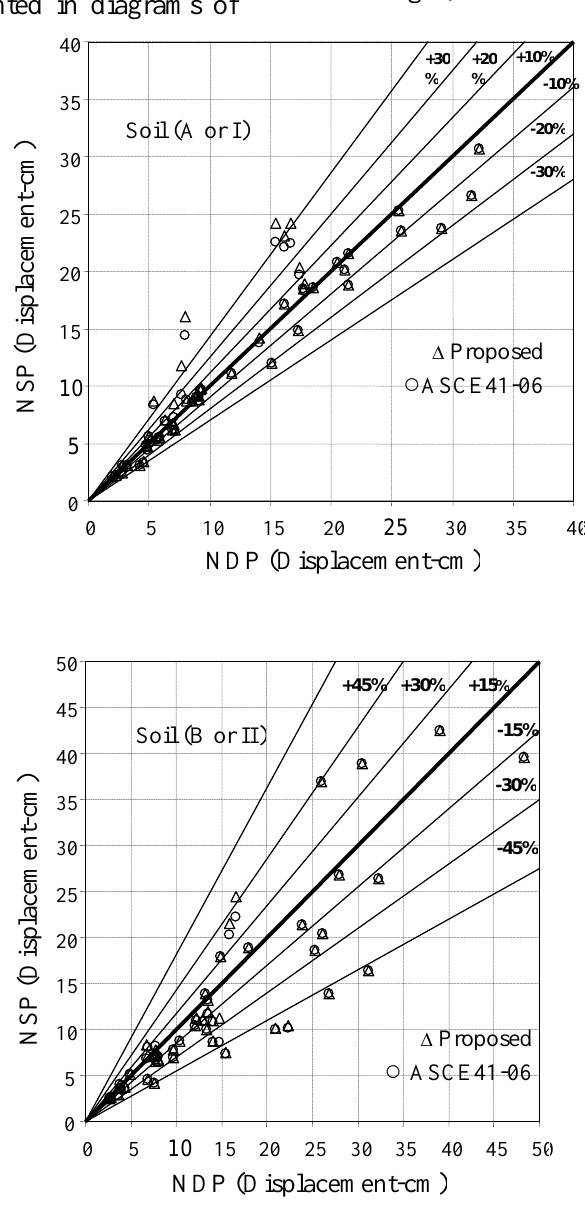
Figure 18 for different soil types. If the two values )Dis( are )Dis( and NSPi NDPi DisDis )( NDPi equal, the ratio finds the unit, in )( NSPi and any other values beyond unit show the larger difference between two estimations. DisDis )( NDPi If ratio is denoted as X , then i )( NSPi  1001X  may demonstrate the per i cent deviation of this ratio in respect to the bisector (shown in lines passing through the